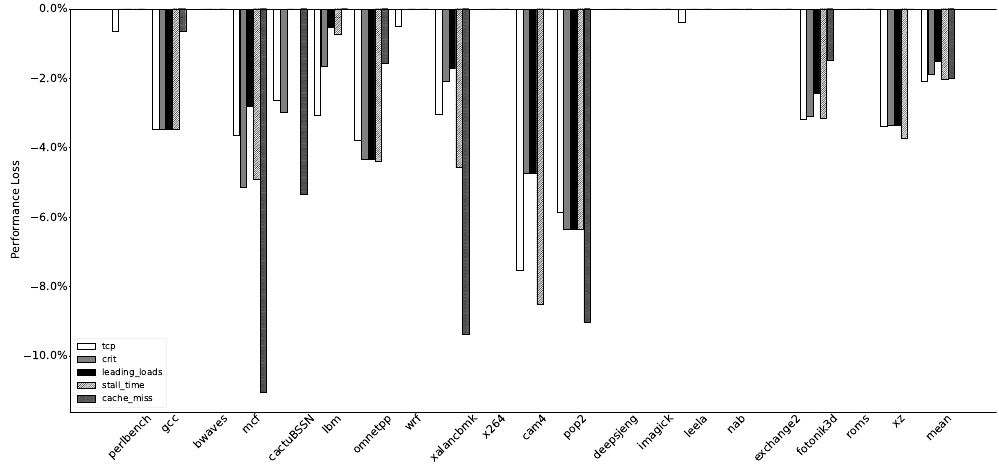
Figure 8. Comparison of performance of power management